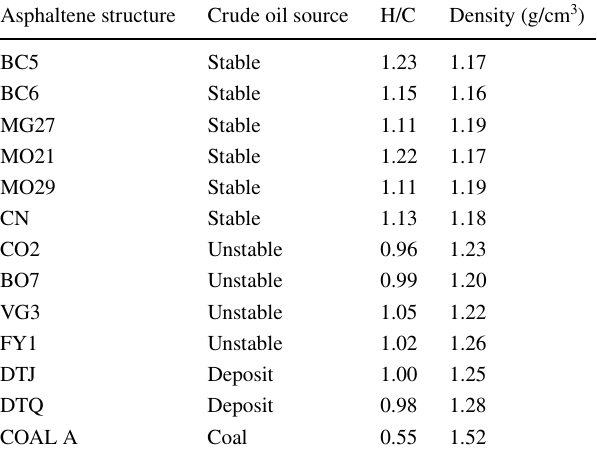
Table 1 Properties and experimental densities of asphaltene struc-